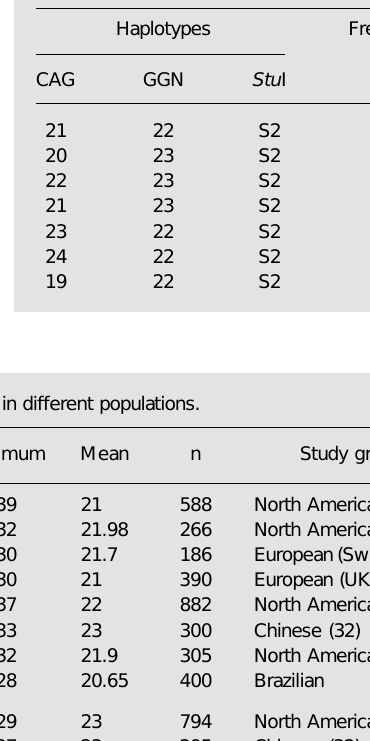
Table 2. Estimated haplotype frequencies for the AR gene.